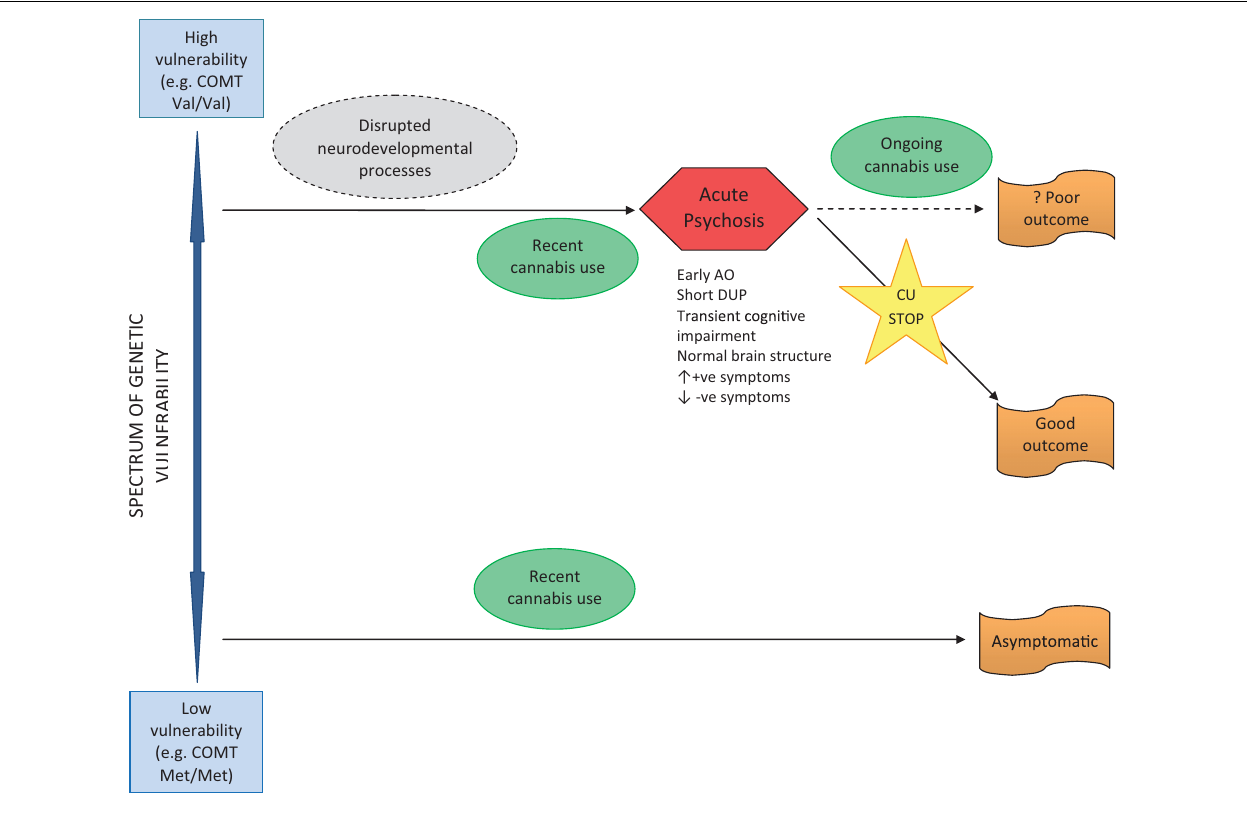
FIGURE 3 | Pathway to psychosis in recent use cannabis users